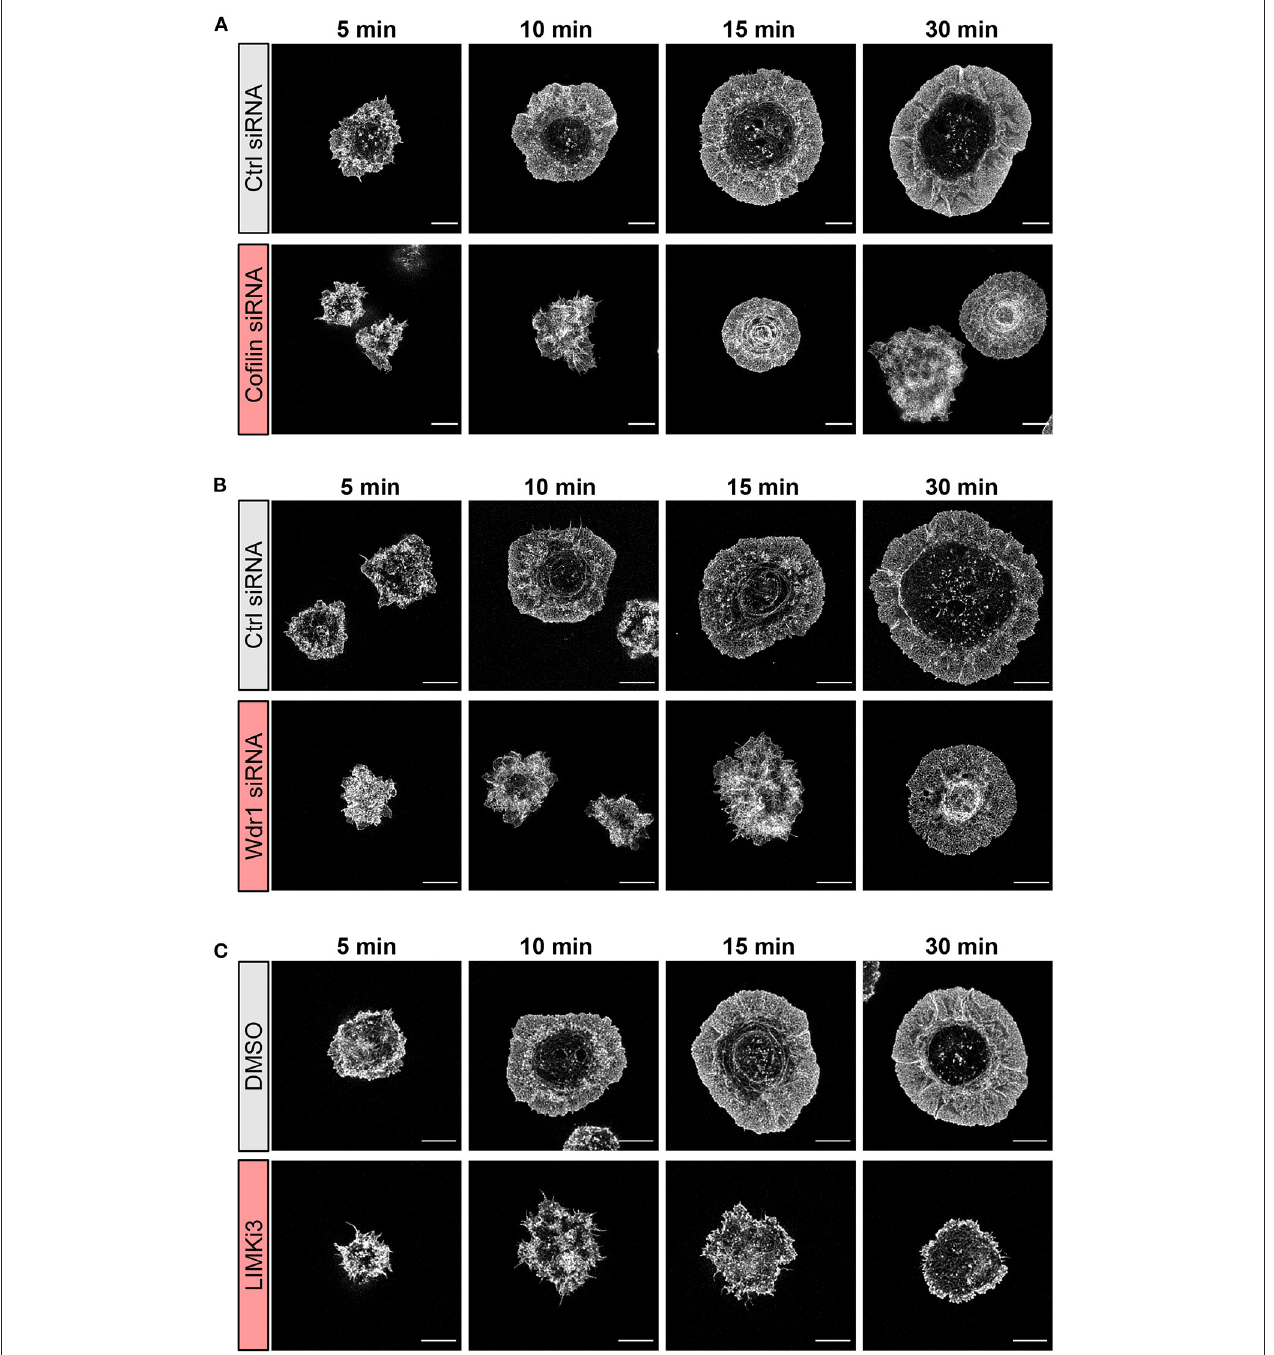
FIGURE 3 | The Wdr1-LIMK-cofilin network shapes actin network architecture in B cells spreading on immobilized anti-IgG. A20 B cells were (A) transfected with control (Ctrl) siRNA or cofilin siRNA, (B) transfected with control (Ctrl) siRNA or Wdr1 siRNA, or (C) pre-treated with DMSO or 50 µ M LIMKi3 for 1h. The cells were then allowed to spread on anti-IgG-coated coverslips for the indicated times before being fixed, stained for F-actin, and imaged by STED microscopy. Representative images are shown. Scale bars: 5 µ